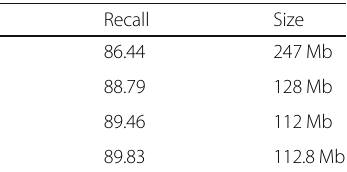
Table 3 Time performance comparison